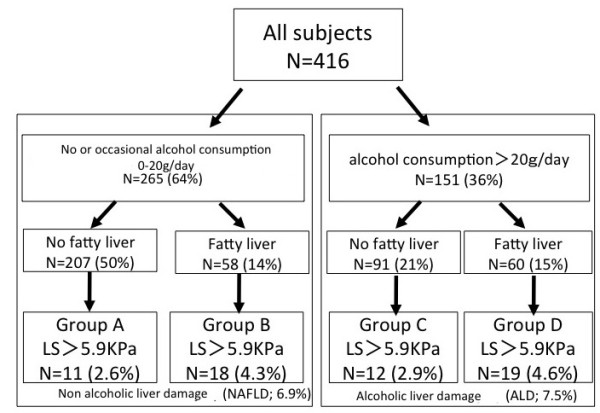
Comparison of liver stiffness among four groups based on alcohol consumption and fatty liver. All participants were assigned to two groups based on alcohol consumption and then each group was further divided into two subgroups with or without fatty liver according to ultrasonography (Groups A, B, C, D). About 7% (6.9% and 7.5%) of all participants had LS above 5.9 kPa among those with NAFLD or ALD regardless of fatty liver.